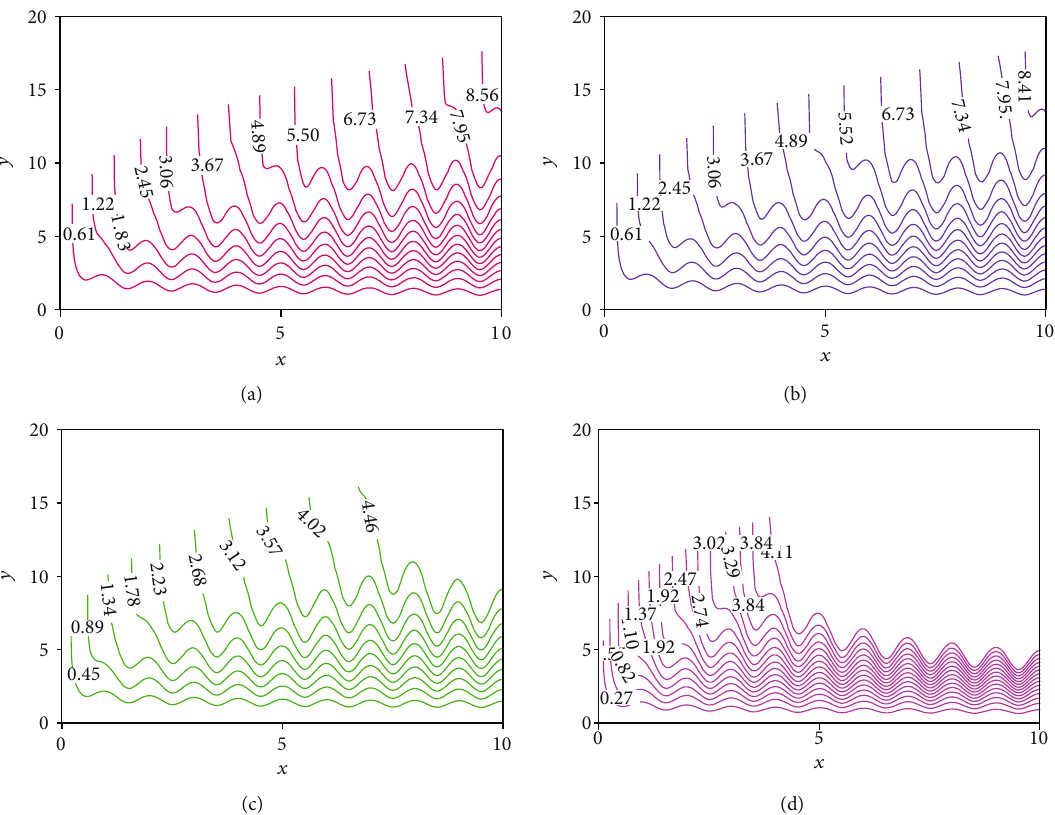
Figure 4: E ff ects of streamlines while Pr = 1 : 0 and α = 0 : 3 , for (a) γ = 0 : 0 , (b) γ = 0 : 1 , (c) γ = 0 : 2 , and (d) γ = 0 : 3